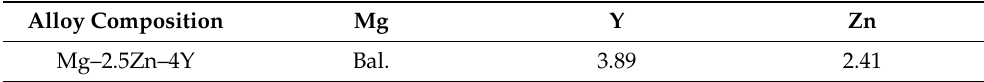
Table 1. The actual compositions of an as-extruded Mg-2.5Zn-4Y (wt%). Alloy